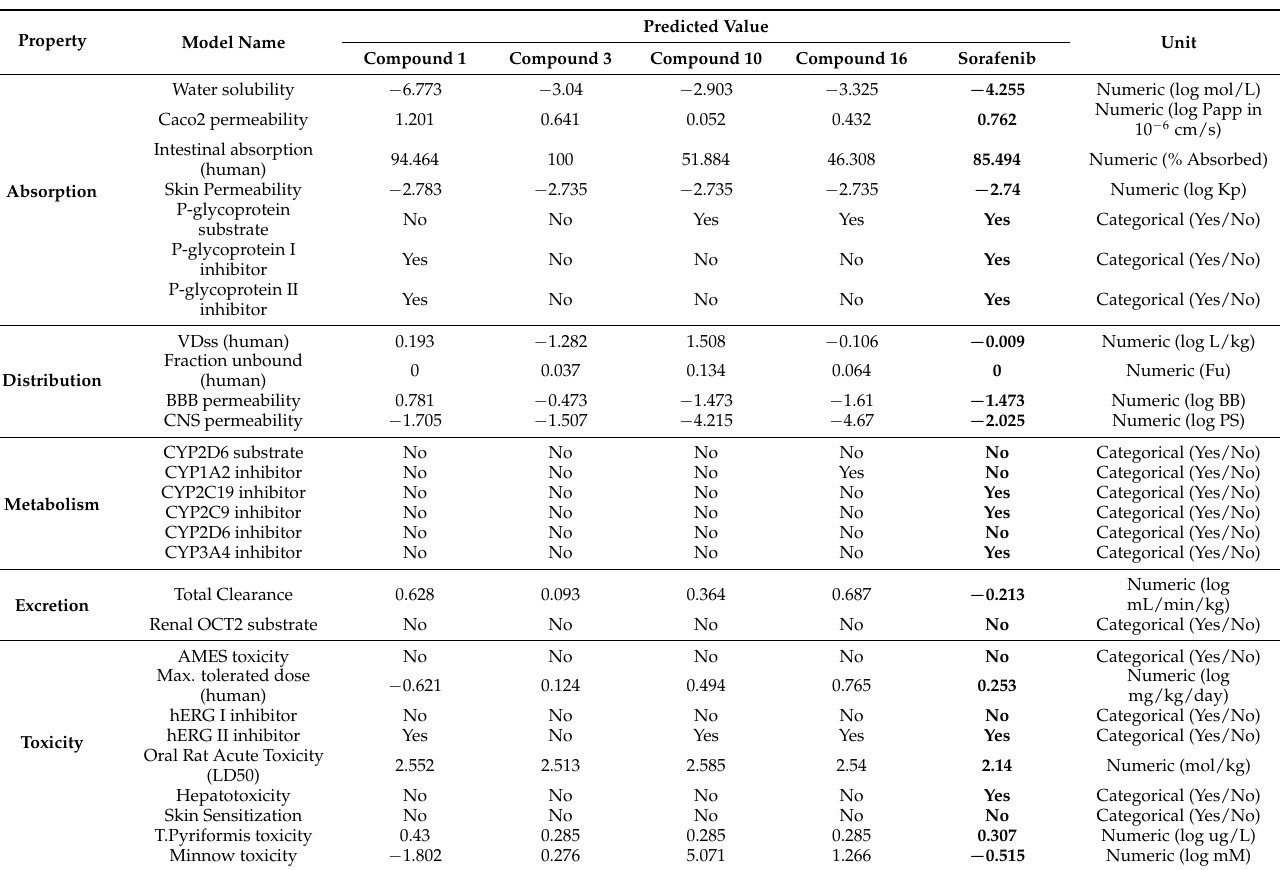
Table 4. The ADMET analysis of the most active isolated